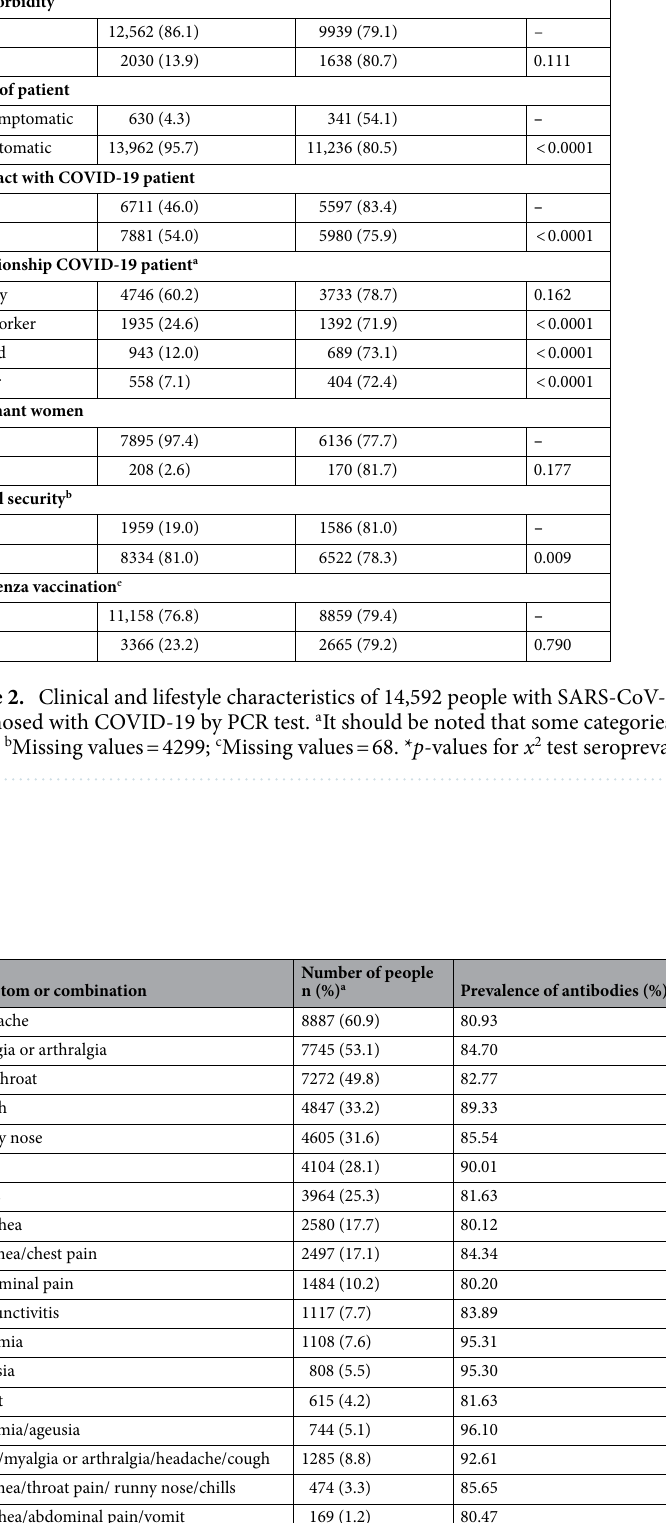
Table 3. Prevalence of antibodies by symptoms in 14,592 people diagnosed with COVID-19 by PCR test. * p -values for x 2 test seroprevalence within symptoms. a Total of seropositive cases = 11,577; It should be noted that some categories could be counted more than once. P-values in bold show which are equal to or less than 0.05.